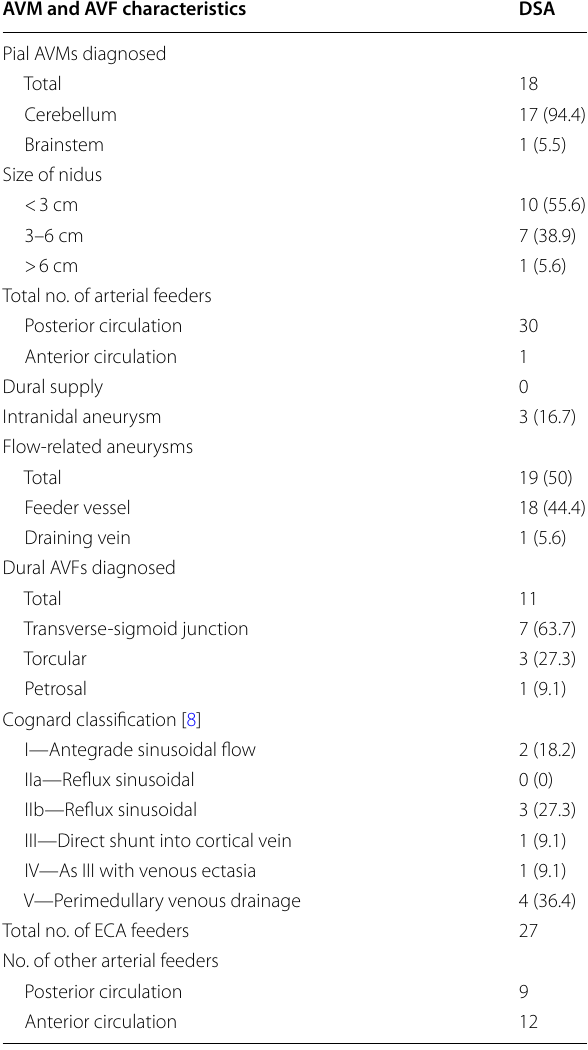
Table 2 Characteristics of AVM and dAVF in our study AVM and AVF characteristics